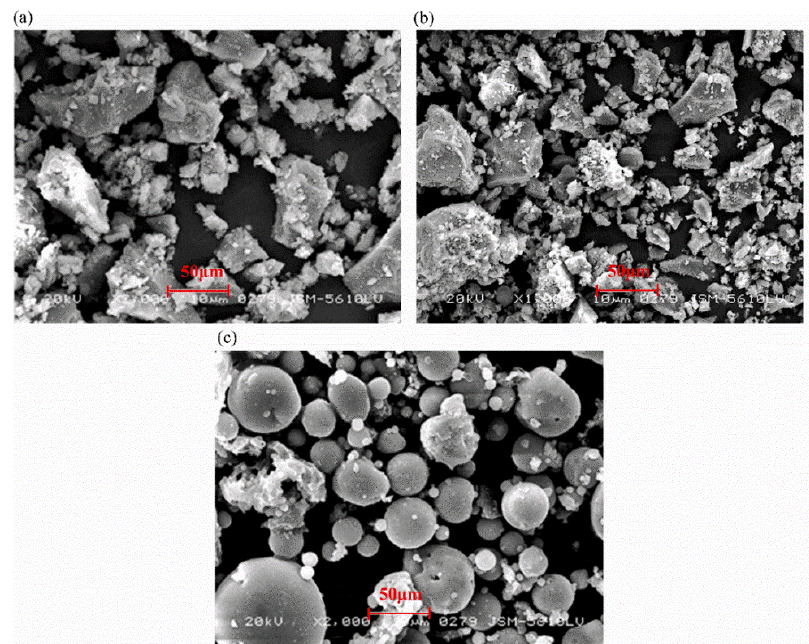
Figure 1. SEM micrographs of ( a ) cement, ( b ) FGPS and ( c ) fly ash.